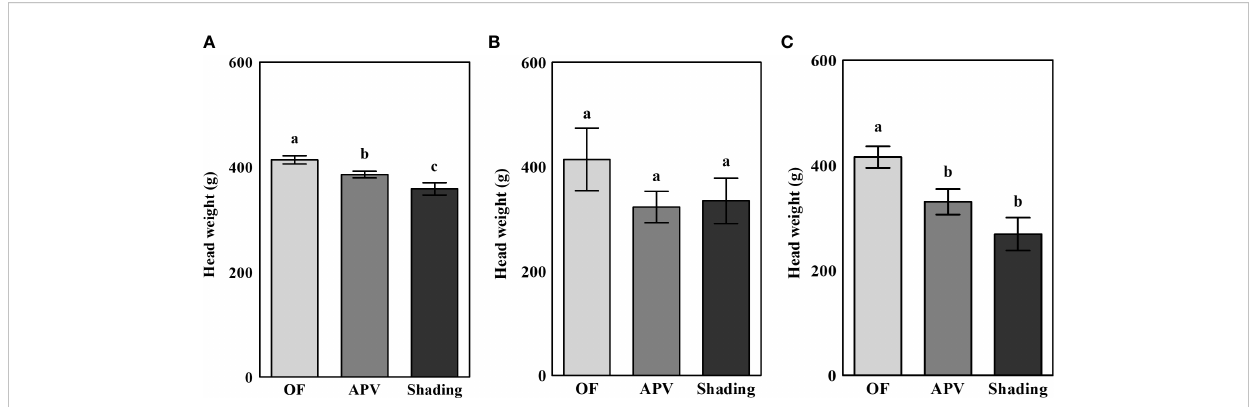
FIGURE 2 The average head weight of fall 2021 ‘ Earlyyou ’ (A) , spring 2022 ‘ Earlyyou ’ (B) , and ‘ Youil2ho ’ (C) . OF, open- fi eld; APV, agriphotovoltaic system. Head weight was measured after cutting the stem length to 8 cm. The weight of 20 broccolis for each treatment was considered as one replication. Lowercase letters indicate signi fi cant differences among treatments within the same cultivar and year by HSD Tukey ’ s test ( n = 3, p < 0.05).